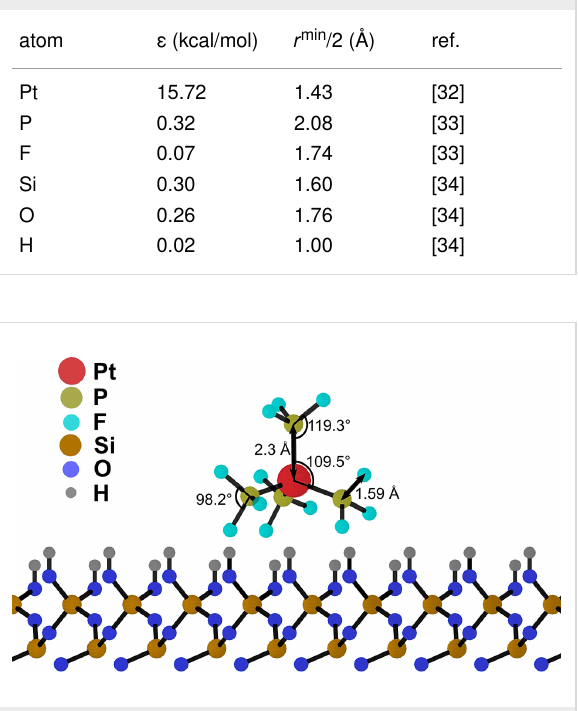
Table 2: Parameters of the Lennard-Jones potential describing the van der Waals interaction. ε is the depth of the potential energy well and r min is the interatomic distance corresponding to the potential energy minimum.